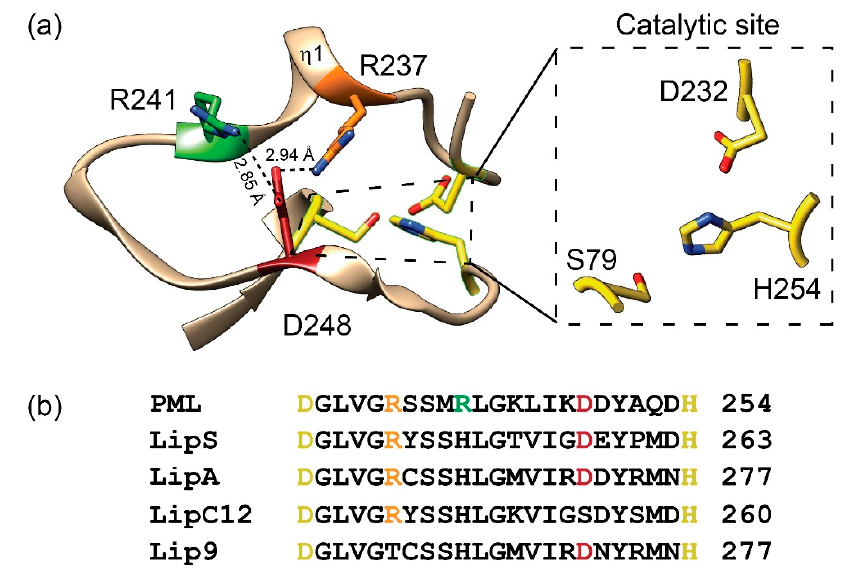
Figure 1. Active-site structure of PML and multiple sequence alignments. ( a ) View of the salt bridges involving R237 and R241 on the helix η 1 and D248 on the connecting loop. The catalytic D232 and H254 are located on the connecting loops before and after the helix η 1, respectively. ( b ) Multiple sequence alignments of OST lipases. PML [14], LipS [15], LipA [28], LipC12 [29], and Lip9 [30]. Catalytic serine, aspartate, and histidine (yellow), R237 (orange), R241 (green), and D248 (red). Alanine-scanning mutations were produced in the R237, R241, and D248 residues. A double alanine substitution (R237A/D248) was also generated to confirm the absence of salt bridges. This paper reports that salt bridges holding the active-site catalytic residues of PML in the correct conformation and orientation play a distinct role in maintaining its stability in thermal and organic